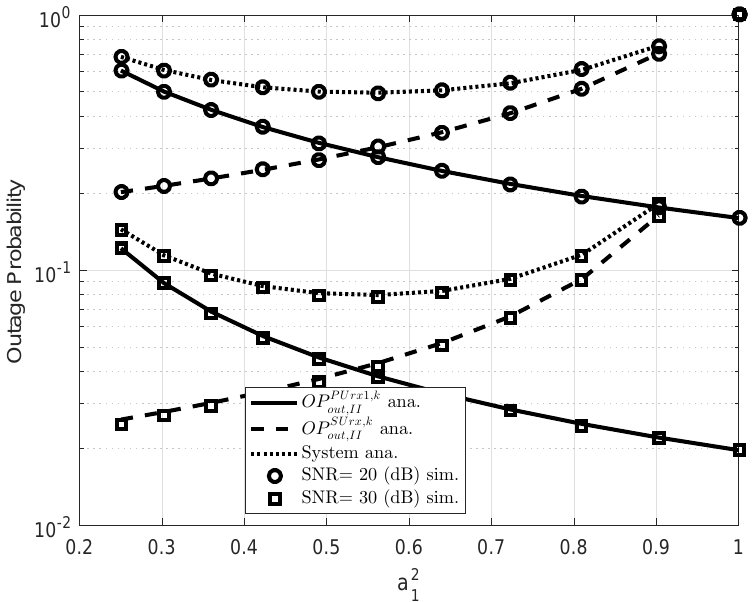
Figure 8. Scheme 2: Performance of PUrx 1 and SUrx with a 1 as varying SNR ( R PUrx 1 = R SUrx = 0.1, K =